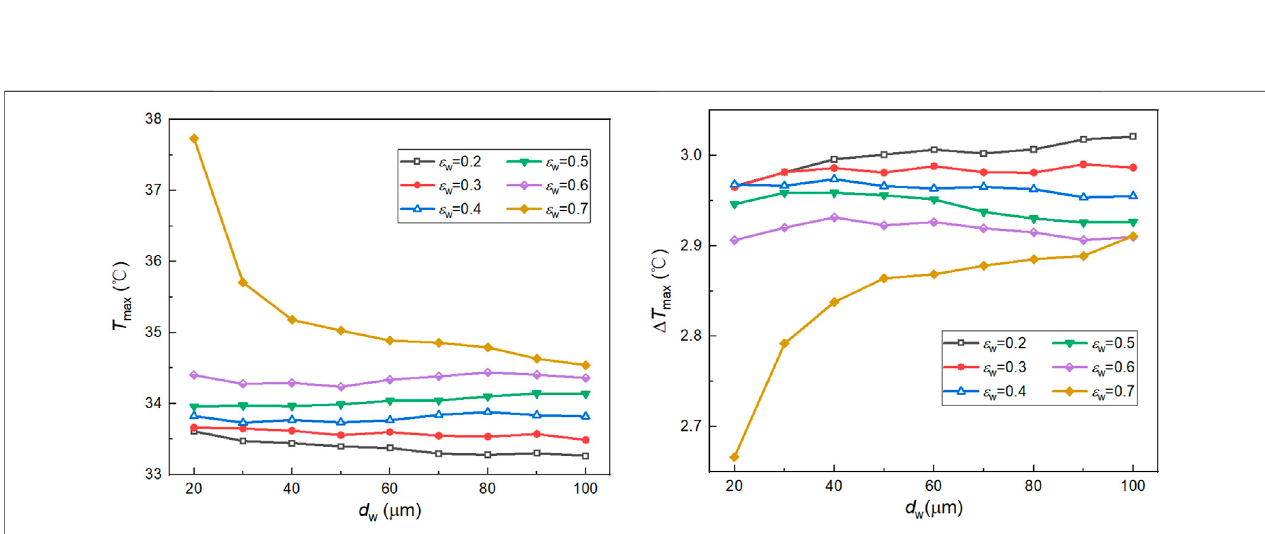
FIGURE 11 | (A) In fl uence of ε w and dw on battery maximum temperature. (B) In fl uence of ε w and dw on battery maximum temperature difference.